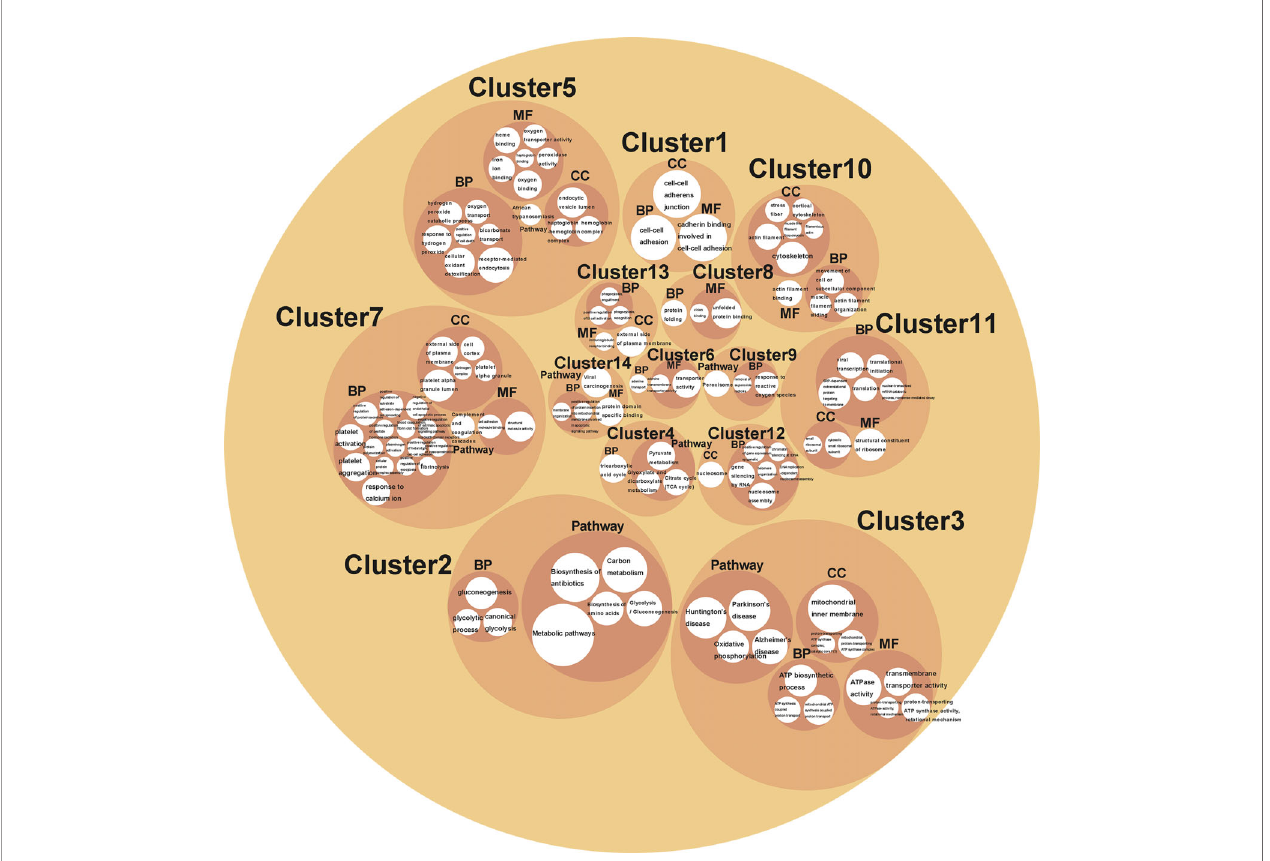
FIGURE 5 | A circle packing chart showing the cluster analysis results. The white circle size is associated to the count of genes enriched on each BP, MF, CC, or pathway. The meaning that each circle represented is annotated in or nearby the